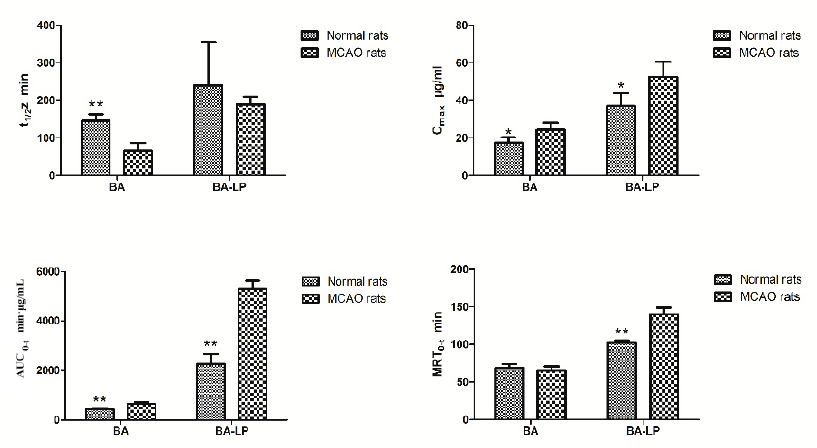
Figure 5. The statistical significances of t 1/2 z, C max , AUC 0–t and MRT 0–t between the normal and MCAO rats ( n = 5, * P < 0.05, ** P < 0.01).